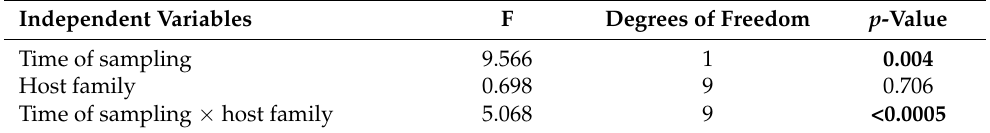
Table 3. Effect of selected risk factors on nematode fecal egg count (logarithmically transformed) in herbivores housed in the studied faunistic park, obtained by a generalized linear mixed model. In bold: significant predictors of